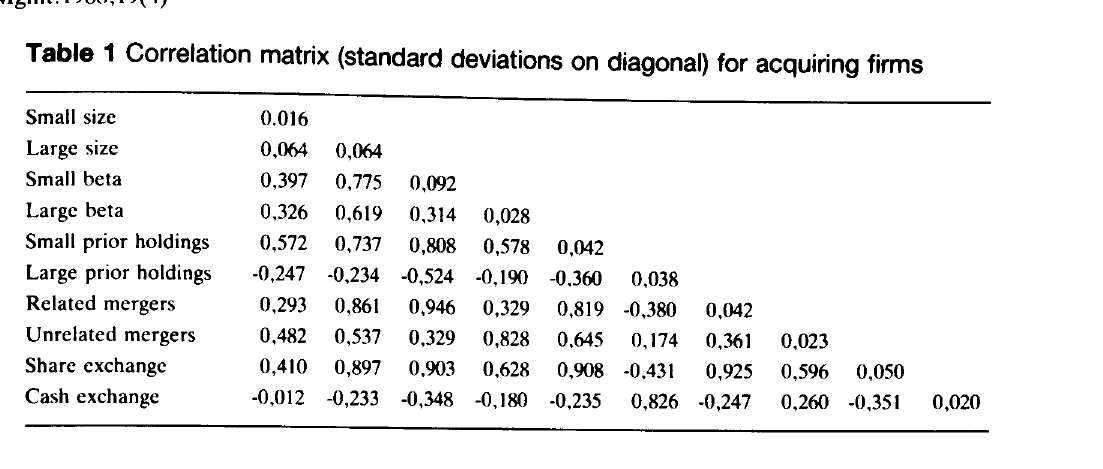
Table 1 Correlation matrix (standard deviations on diagonal) for acquiring firms